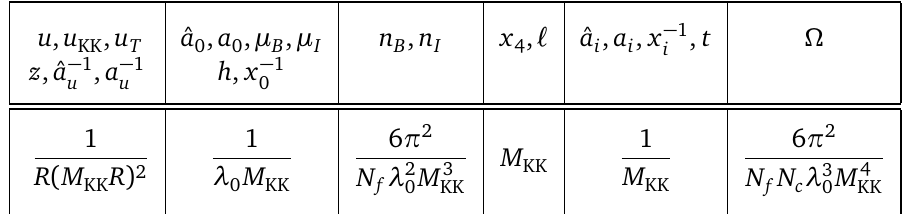
= X R ) 2 ] , x M KK 4 4 KK